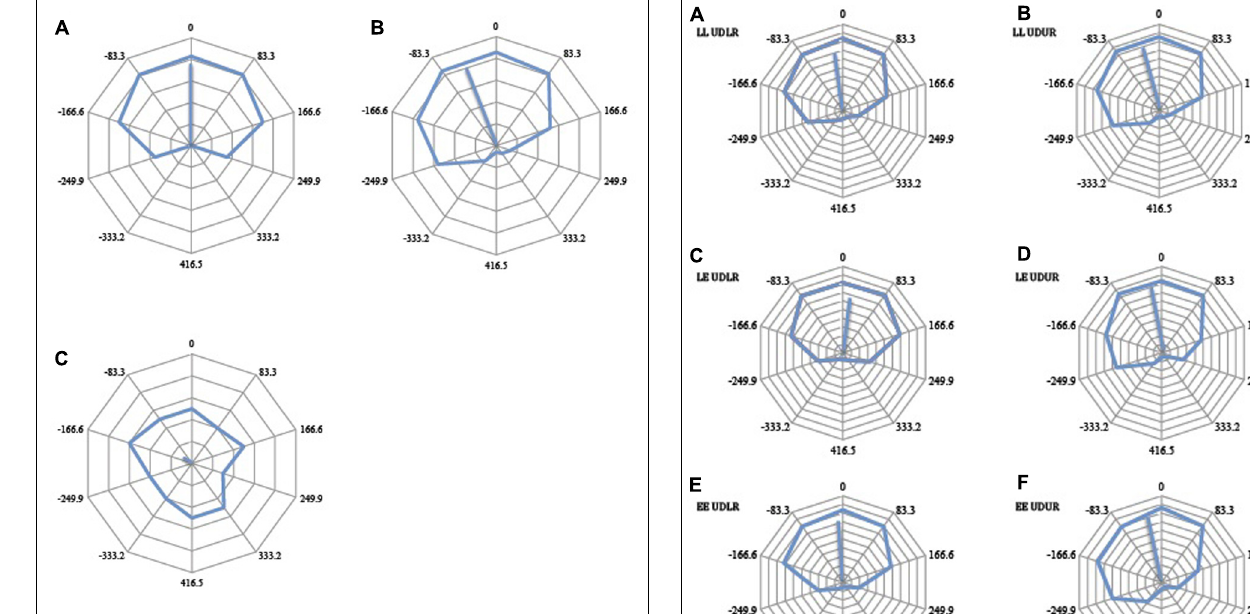
FIGURE 6 | Illustration of potential outcomes. (A) The veridical response curve should the subject perceive the two motion stimuli as they happened in real time. At Oms offset, the test motion would be moving right for the entire duration that the reference motion was moving up. At 417 ms offset (half period), the test motion would be moving left for the entire duration that the reference stimulus was moving up. At 208 and − 208 ms offsets (quarter period either way), the test motion would be moving right half of the time and moving left the other half of the time, or vice versa, while the reference motion was moving up. At such quarter-period offsets, if there were to be no perceptual asynchrony and subjects perceive the two motion stimuli in real time, they would judge the direction of the test motion to be either predominantly left or predominantly right, as the reference motion was moving up, with 50% probability. (B) If neural responses do not mirror the temporal conjunction of events as they happen in real time, the response curve would be rotated; a clockwise rotation would indicate that the test motion is perceived after the reference motion (positive perceptual asynchrony) while an anticlockwise rotation would indicate that the test stimulus is perceived first (negative perceptual asynchrony). Each data point is represented as a vector in polar space, and the average angular shift is calculated from the mean vector of 10 vectors. The angular shift quantifies the perceptual asynchrony between the reference motion and the test motion. The associated mean resultant length (MRL) of the vector quantifies the internal consistency of responses (see main text). (C) A short vector suggests an inconsistent and randomly distributed response. More internally consistent responses would be given more weight than inconsistent and randomly distributed responses.